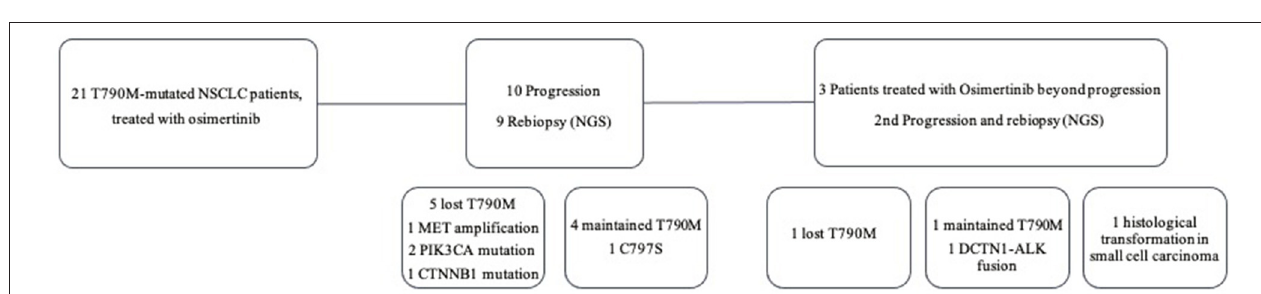
FIGURE 2 | Treatment and resistance profile of NSCLC patients post-osimertinib progression.